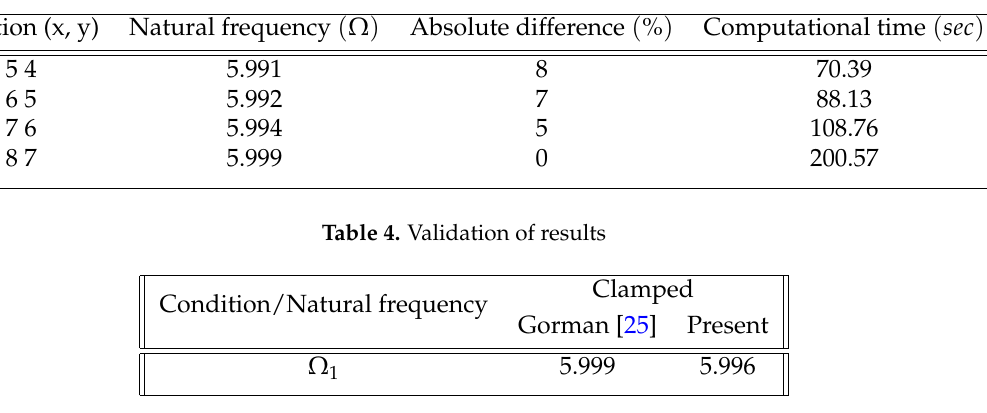
Table 3. Convergence criteria based on the number of iteration ( n ) in the solutions of circular plate deflection